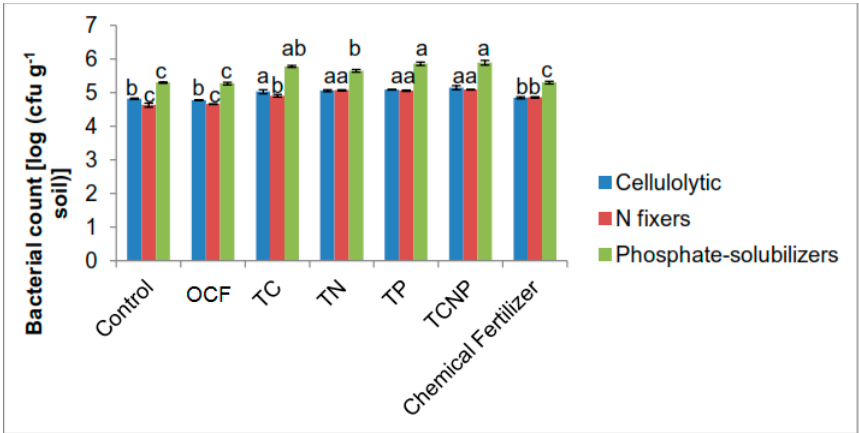
Figure 2. Population of cellulolytic, nitrogen-fixing and phosphate-solubilizing bacteria in the rhizosphere of maize at fifty-six days after sowing. Di ff erent letters for similar colored bars indicate significant di ff erence between treatment means using Tukey’s test at P ≤